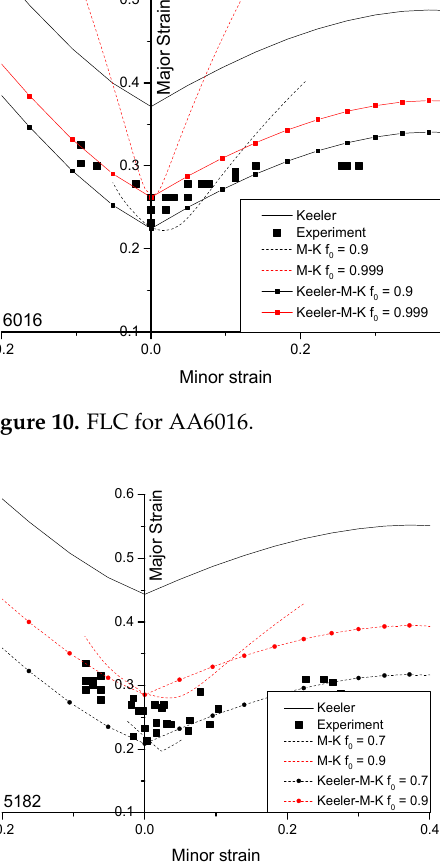
Figure 11. FLC for AA5182.